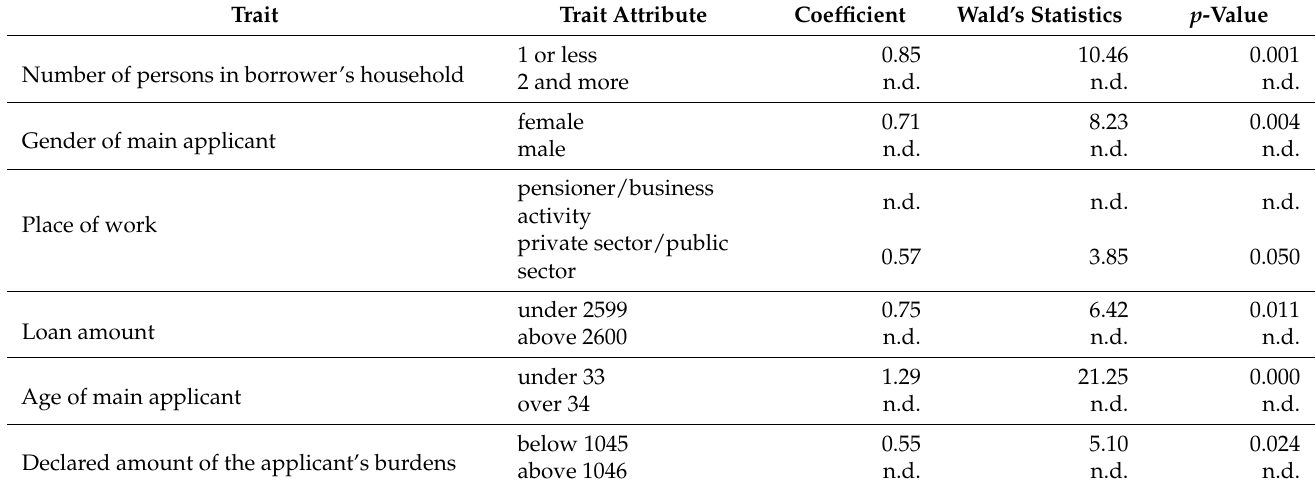
Table 8. Credit risk logit model for Bank D.